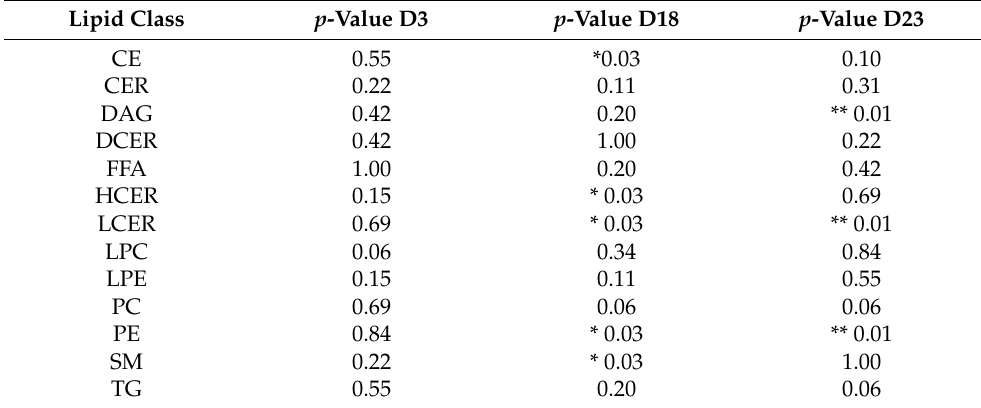
Table 3. Lipid class analysis results from Lipidyzer™, with associated p -values from a Wilcoxon